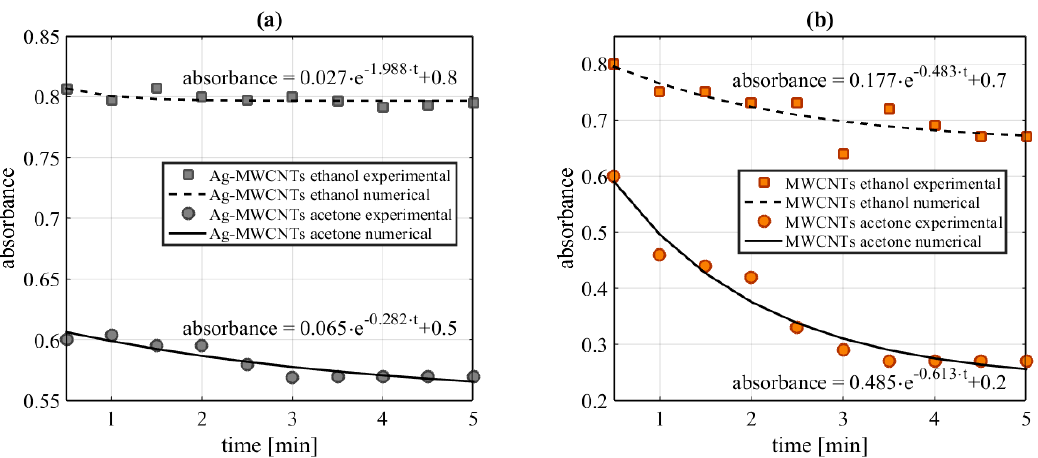
Figure 5. Time dependence of UV-VIS absorbance at 532 nm. ( a ) Ag-MWCNT samples, ( b ) MWCNT samples.